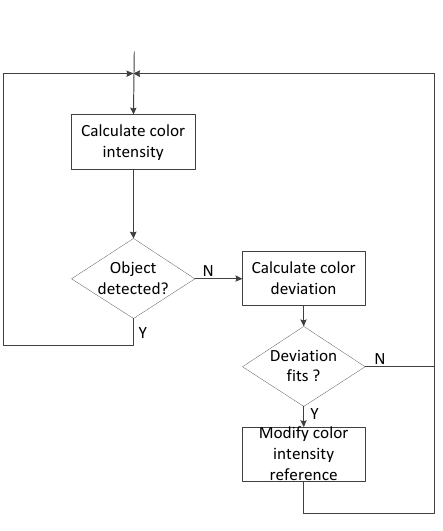
Fig. 1. Overview of object recognition.